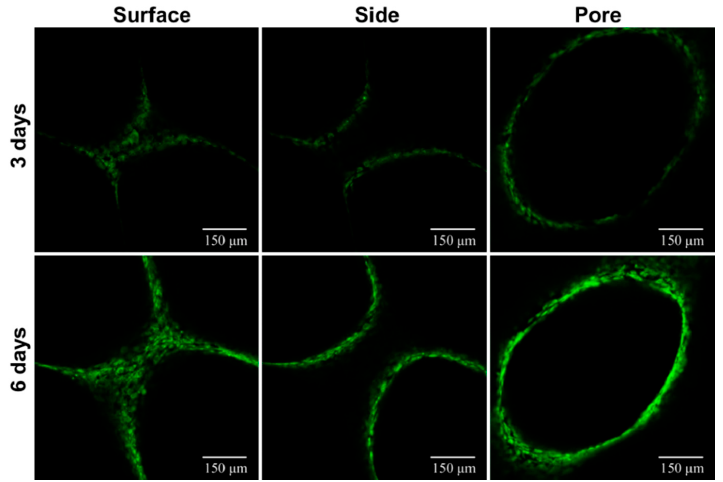
Figure 9. CLSM images of MC3T3-E1 cells-scaffold composites, for determining the distribution of the cells on the